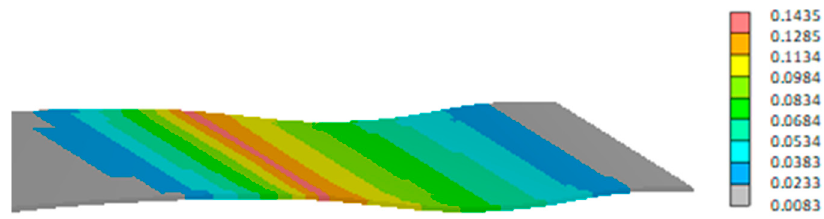
Figure 26. Inverse reserve factors in the skin-extension according to Puck’s failure criterion in cruise-configuration (S4); IRFs are very low.